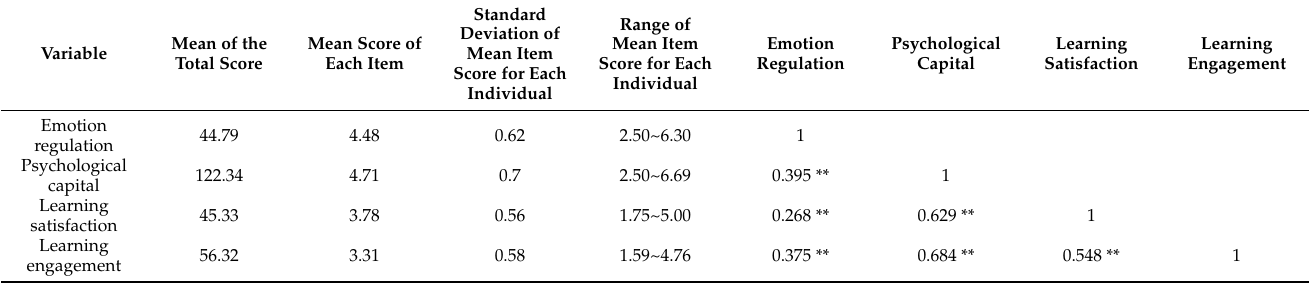
Table 3. The mean, standard deviation, range, and Pearson’s correlation of the study